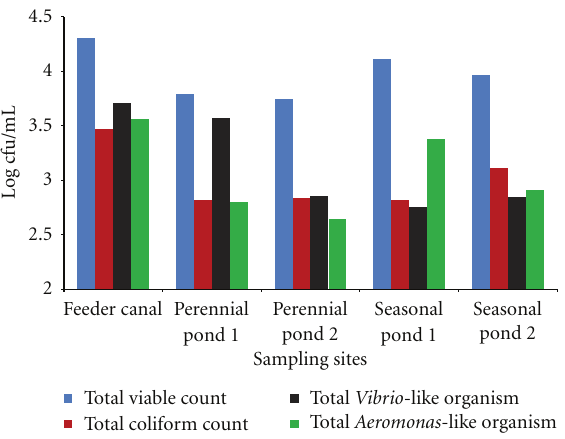
Figure 1: Mean value of bacteriological count of water from di ff erent sampling sites.